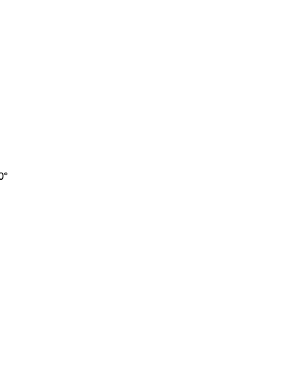
Figure 3. Example of a boost-histogram histogram with circular